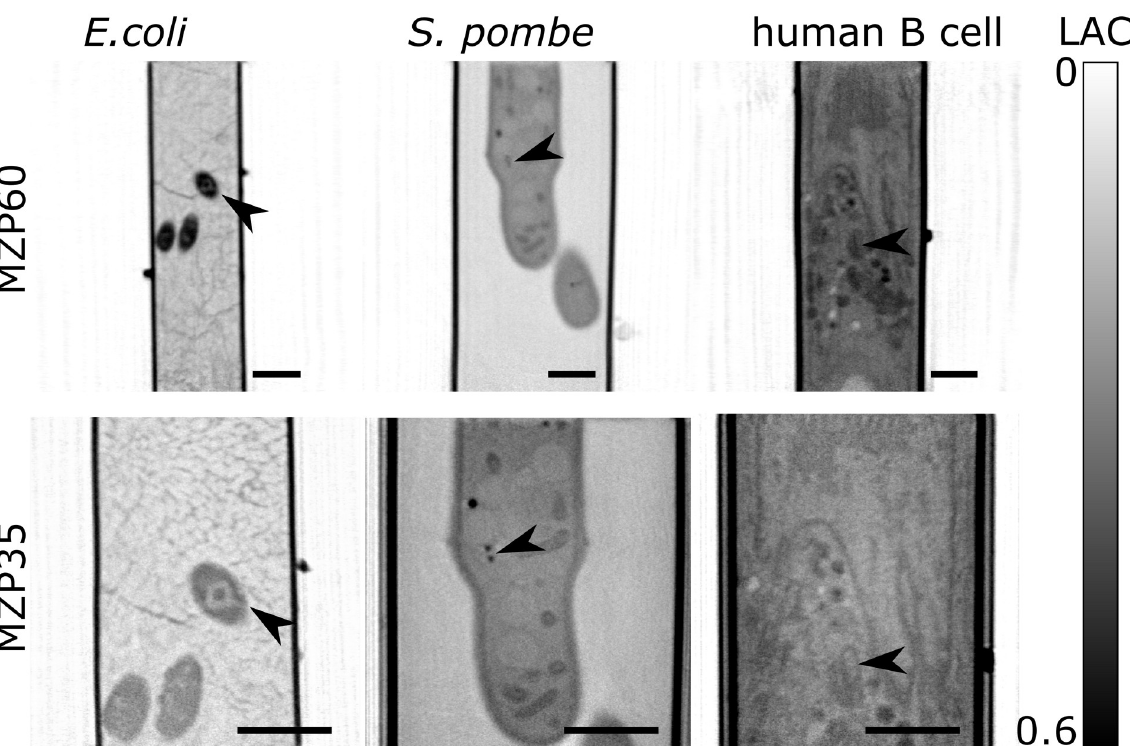
Fig 3. Switchable objectives applicable to diverse cells. Coronal slices from soft x-ray tomography of E. coli , yeast S. pombe and human B cell. Each specimen was imaged with both objectives at XM-2. The scale bar is 1 μ m. The arrows show the same features in both datasets. The colorbar illustrates the difference in linear absorption coefficient from 0 μ m − 1 to 0.6 μ m − 1 .